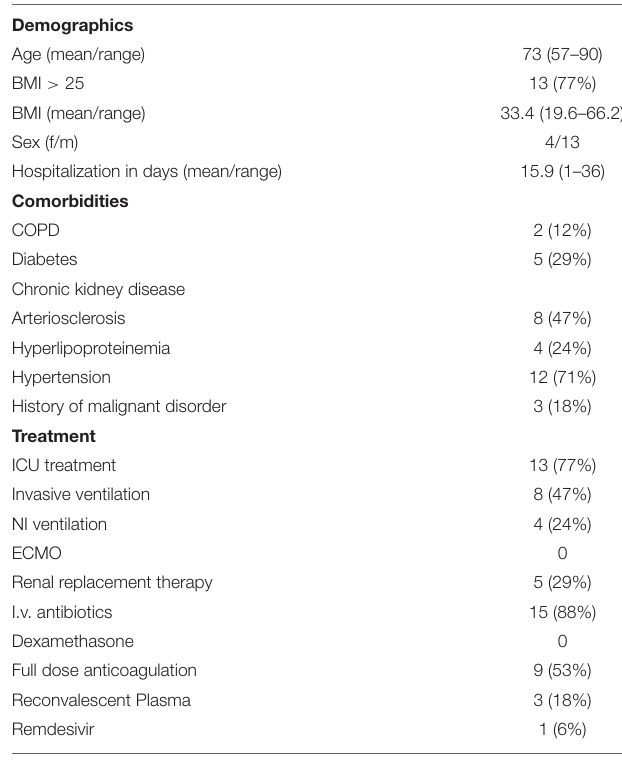
TABLE 1 | Overview over demographics, comorbidities, and systemic treatment of all 17 patients included in the final